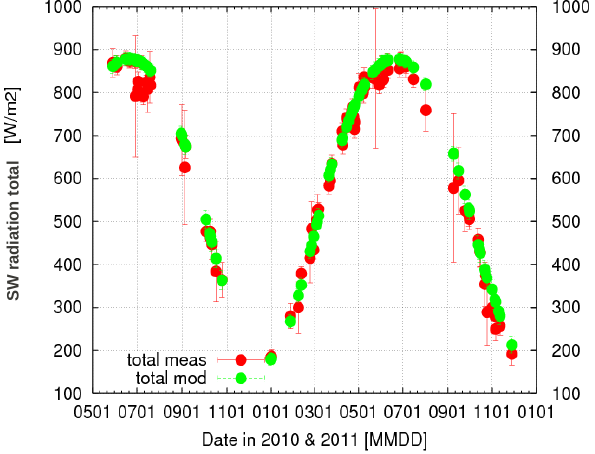
Figure 3. Total cloud coverage from MSG based on pixel-by- pixel analysis using NWCSAF algorithm, mapped onto COSMO- Figure 3: Total cloud coverage from MSG based on pixel- DE model domain and calculated for a 9 × 9 pixel matrix. by-pixel analysis using NWCSAF algorithm, mapped onto COSMO-DE model domain and calculated for a 9x9 pixel